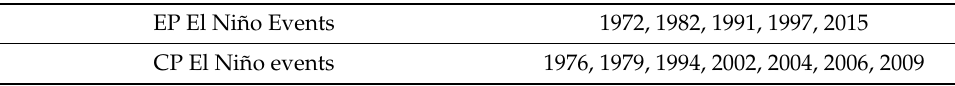
Table 1. Identified El Niño